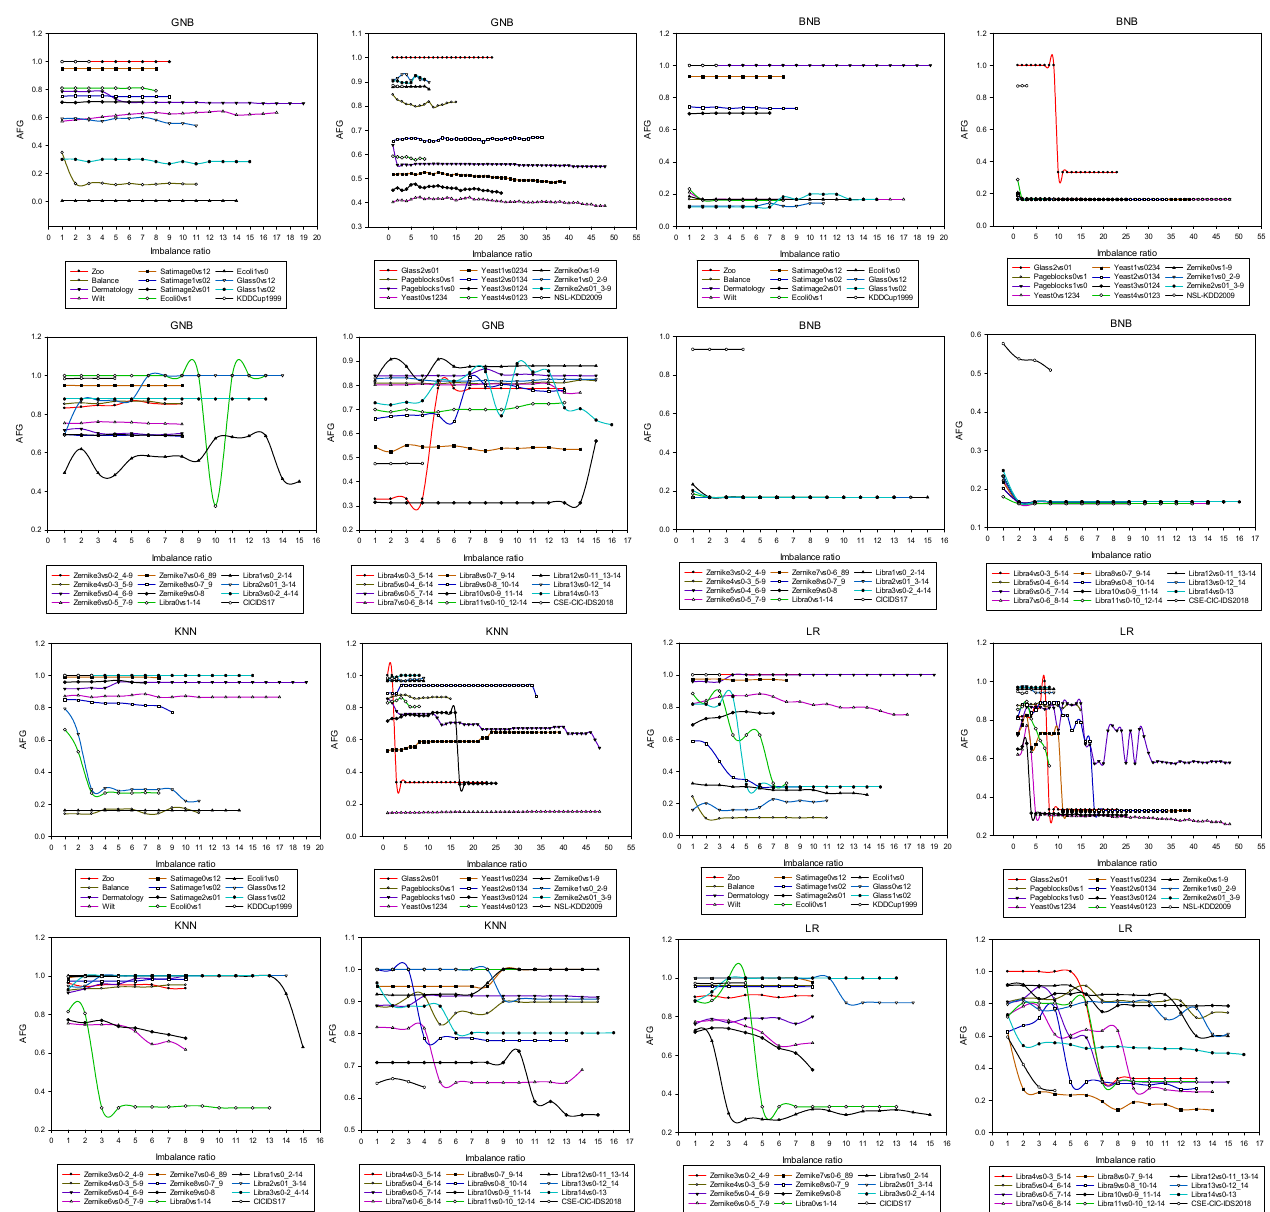
Figure 7. Relationship between varying performance in GNB, BNB, KNN, LR and IR.